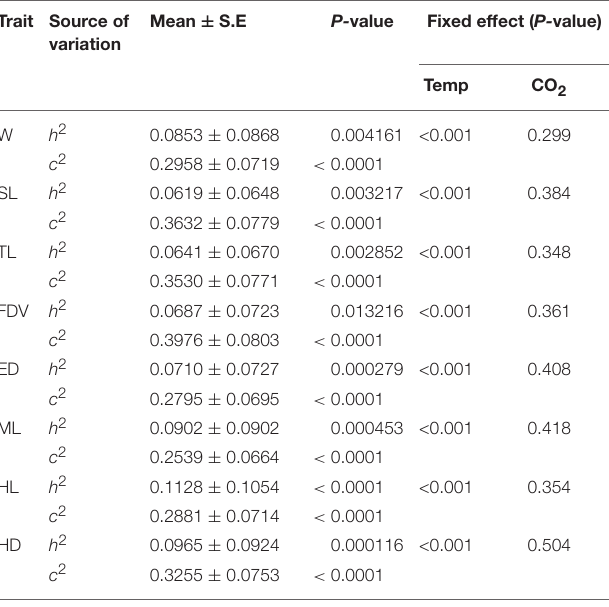
TABLE 2 | Heritability (h 2 ), common environmental tank effects (c 2 ) effects, and direct effects of temperature and CO 2 treatment for 21 dph yellowtail kingfish ( Seriola lalandi ) weight and morphometric traits. Trait Source of variation